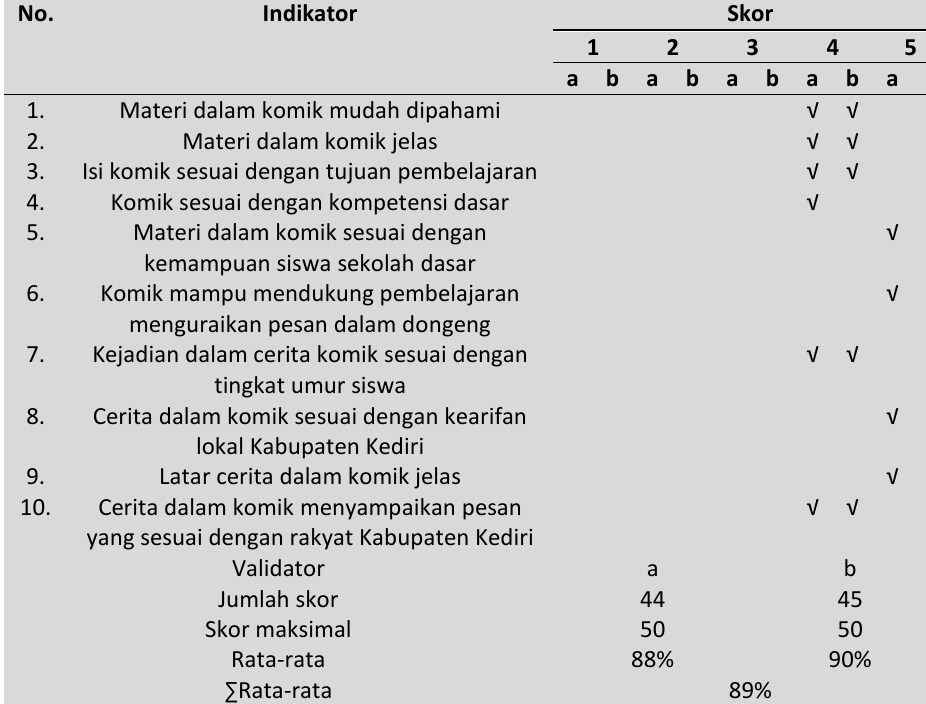
Diadaptasi dari hasil angket validasi